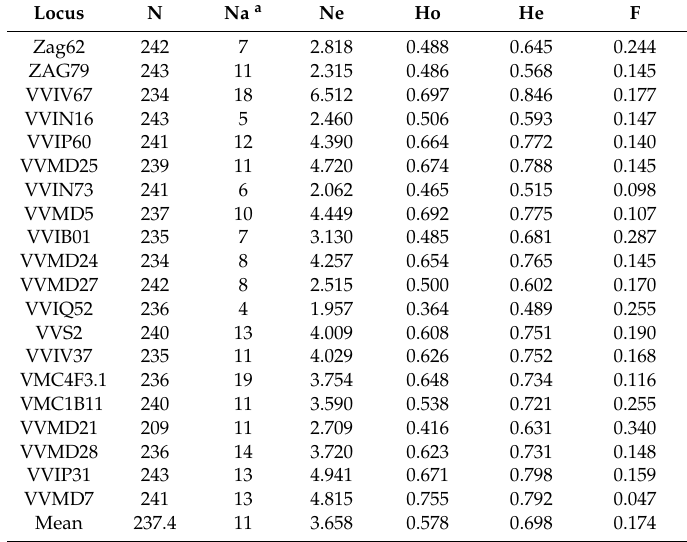
Table 1. Genetic diversity indices calculated for 243 genotypes, including wild and cultivated accessions. Locus